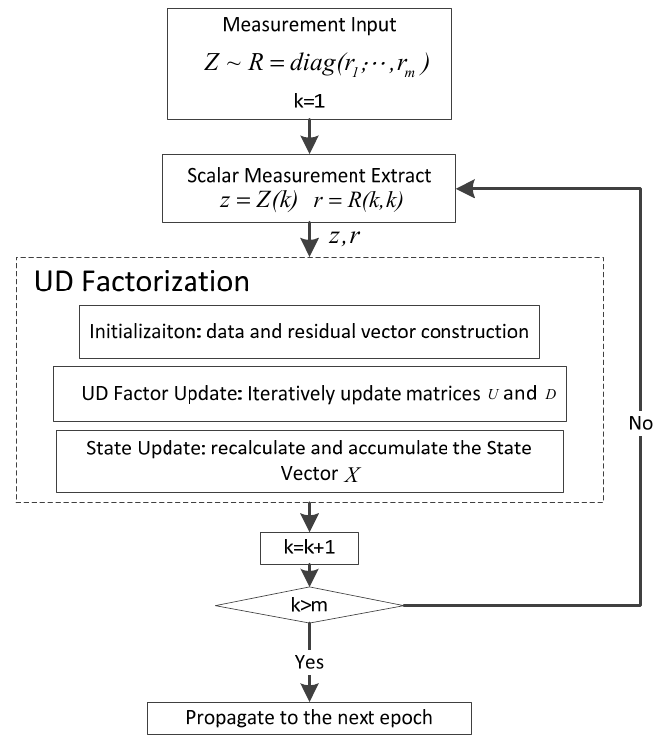
Figure 1. Flow chart of UD-KF Strategy. Table 1. A stepwise implementation of UD factorization.